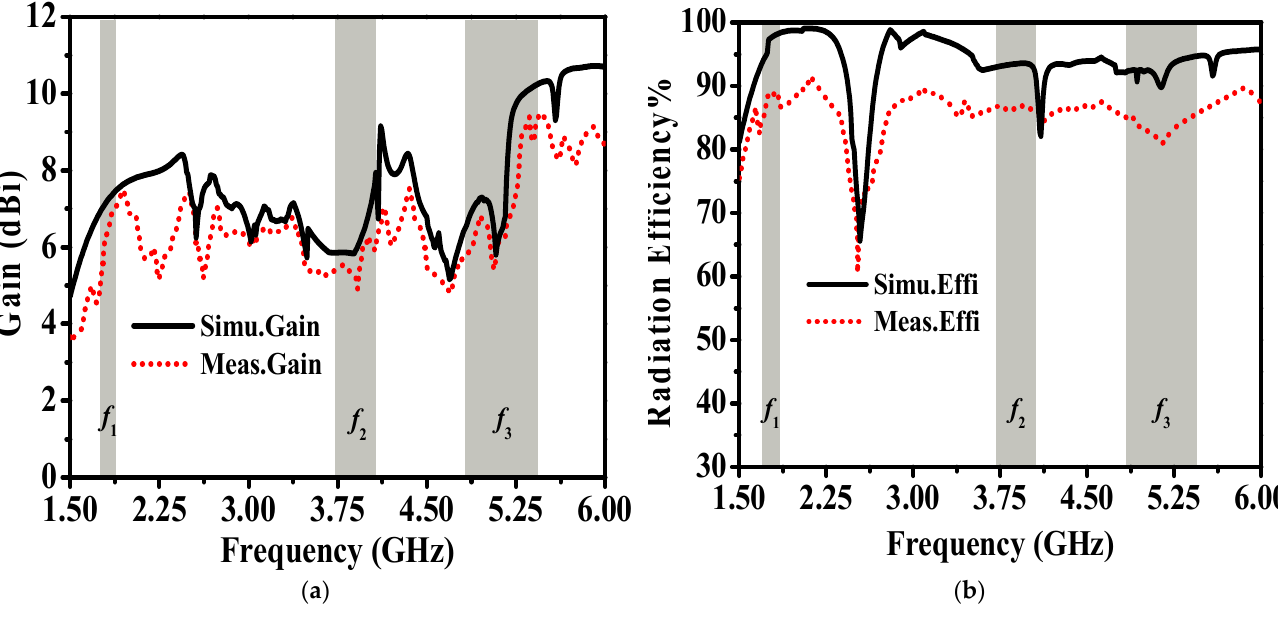
Figure 10. Simulated and measured gains and radiation efficiencies of the designed antenna: ( a ) gain; ( b ) radiation efficiency.